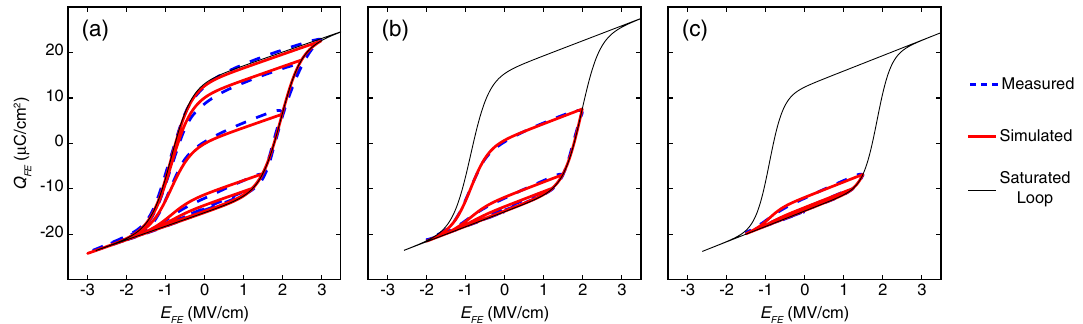
Figure 4. Fitted hysteresis loops based on measured data from a 10 nm HZO sample. ( a ) Fitting based on five experimental hysteresis loops, where extracted P s , P r , E c + , E c − , P offset , and ε FE are 14.66 μC/cm 2 , 14.55 μC/cm 2 , 1.96 MV/cm, − 0.85 MV/cm, − 0.59 μC/cm 2 , and 33.79, respectively. ( b ) Fitting based on three experimental minor loops, where extracted P s , P r , E c + , E c − , P offset , and ε FE are 15.51 μC/cm 2 , 15.45 μC/cm 2 , 1.98 MV/cm, − 0.86 MV/cm, 0.44 μC/cm 2 , and 37.15, respectively. ( c ) Fitting based on two experimental minor loops, where extracted P s , P r , E c + , E c − , P offset , and ε FE are 13.71 μC/cm 2 , 13.70 μC/cm 2 , 1.86 MV/cm, − 0.90 MV/cm, − 1.19 μC/cm 2 , and 38.16, respectively. Even though the extracted model parameters vary somewhat depending on the number of hysteresis loops adopted, the reconstructed saturated loop (Eq. 4b) is much larger than the measured minor loops, alleviating the underestimated